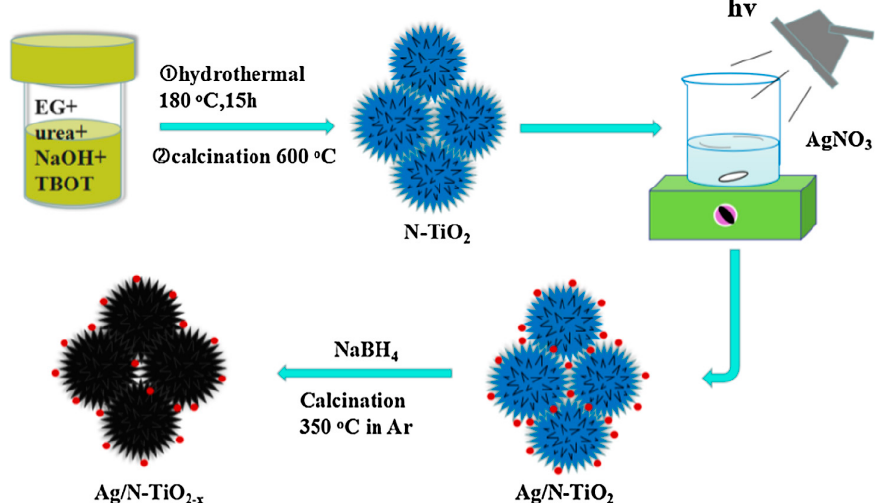
Figure 10. Schematic illustration for preparation of 3D urchinlike Ag/N-TiO 2 − x . Reprinted with permission for ref. [104]. Copyright 2018, Elsevier.